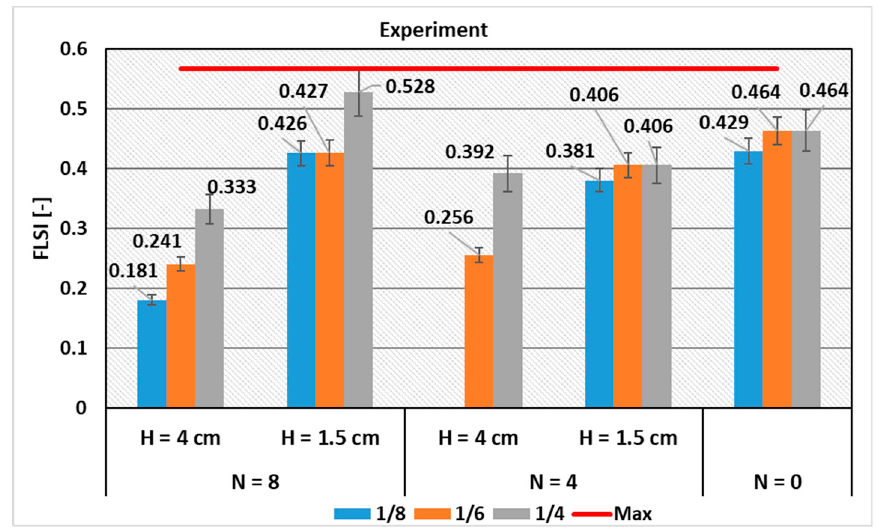
Figure 4. The front layer segregation index (FLSI) from experiments for the bi-size bed and for different drum filling ratios and different baffles heights (H) and numbers (N).